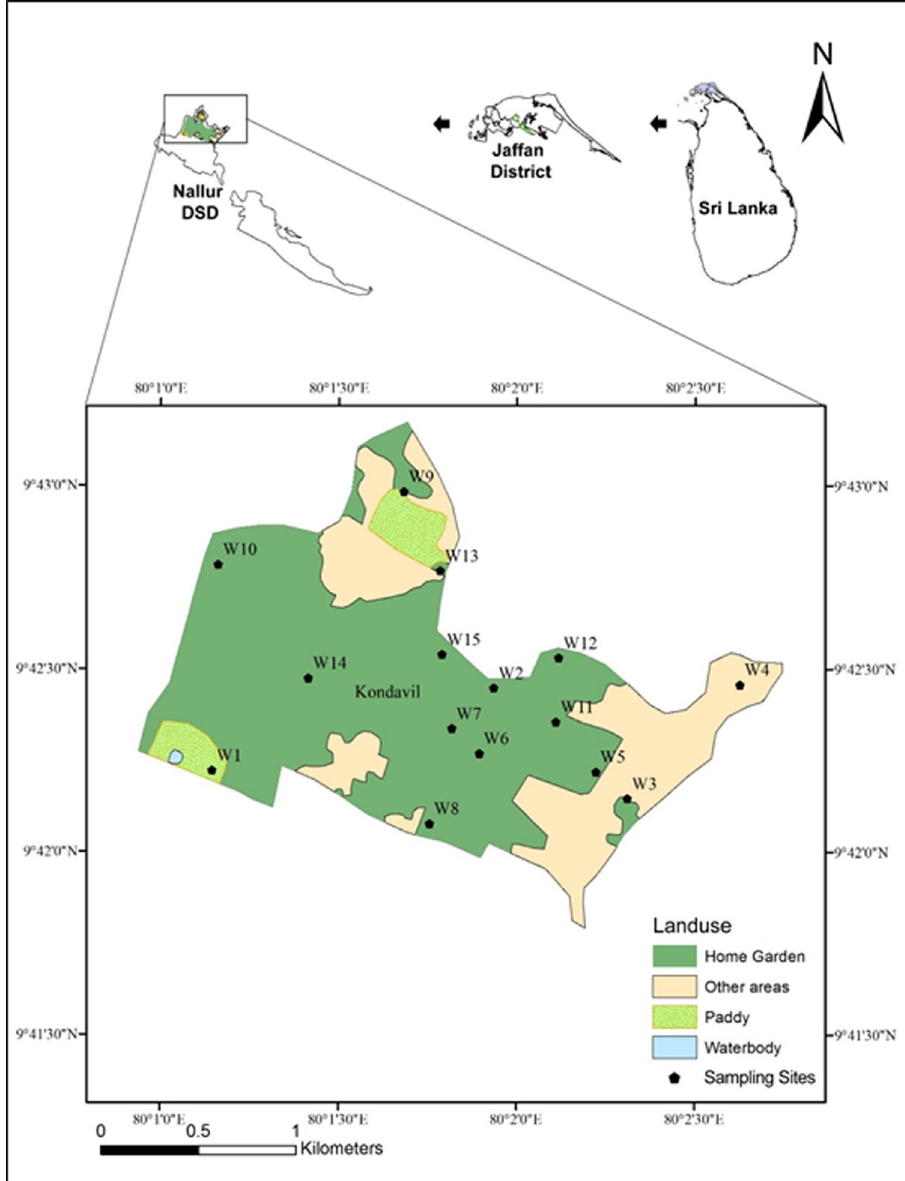
Fig. 1 Map of the study area showing the sampled